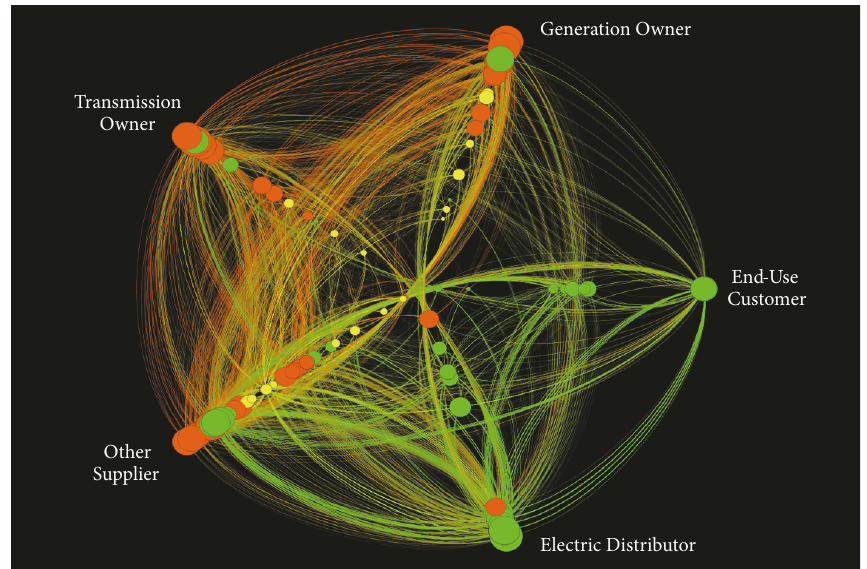
Figure 4: The no voting network in the PJM Members Committee from 2011 to 2015. The node and edge colors correspond to the three different communities detected within the no network.